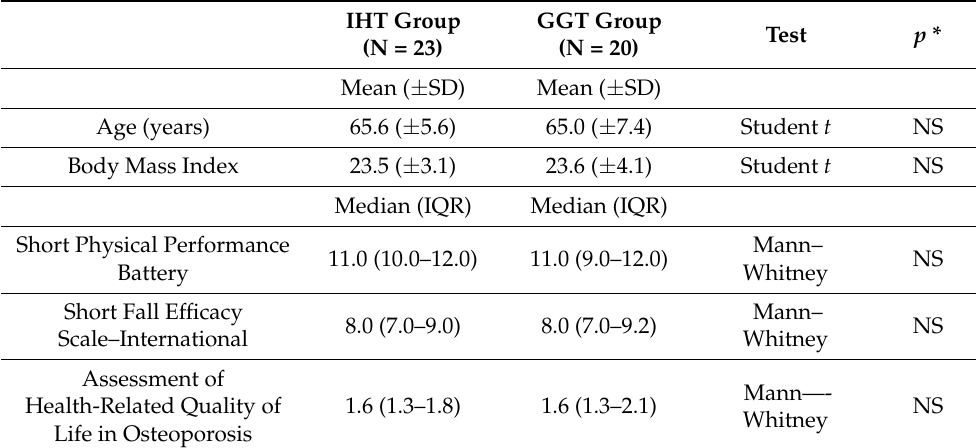
Table 1. Characteristics of the IHT and GGT groups at the baseline assessment and adherence before the